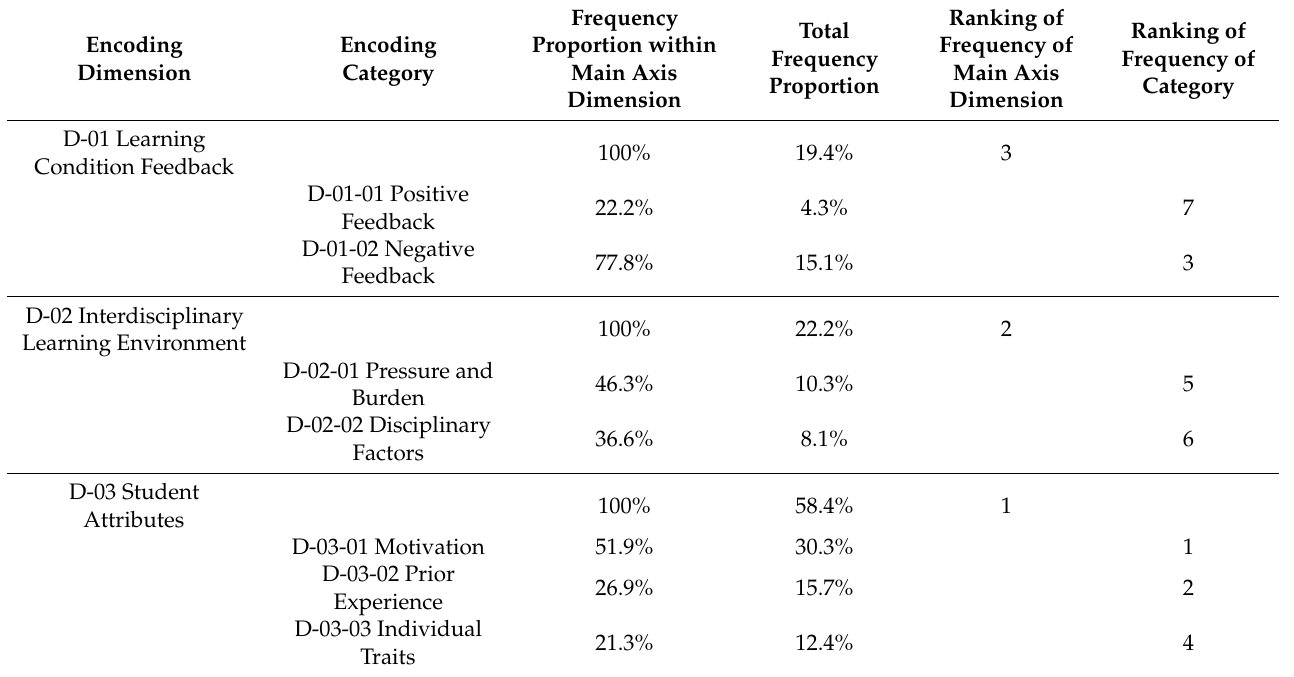
Table 8. Frequency Proportion and Ranking of Each Dimension and Category